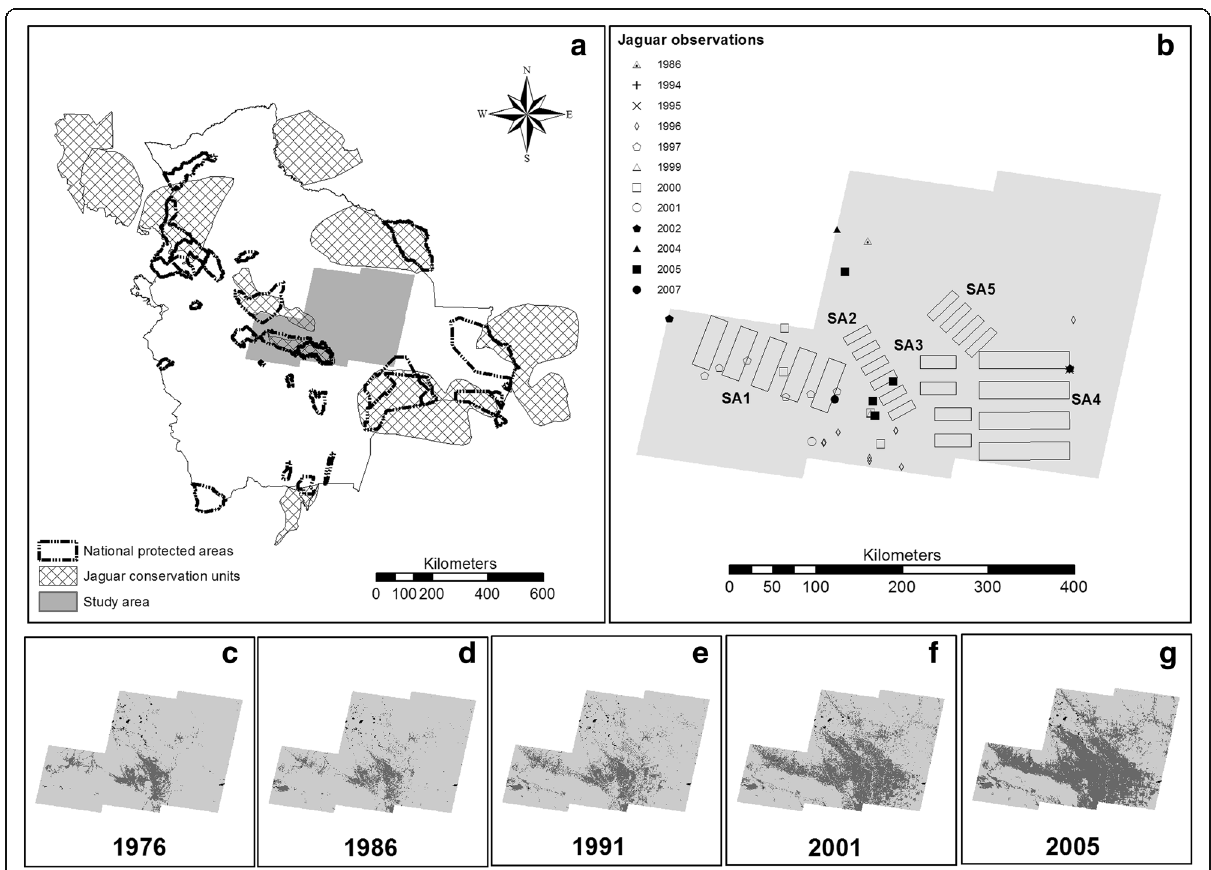
Fig. 1 Location of study area in Bolivia and within national protected areas and jaguar conservation units (Sanderson et al 2002, Rabinowitz and Zeller 2010) ( a ). Jaguar observations between 1986 and 2005 and study area with sampled location ( b ): Chapare region (SA1), northwest colonization zone (SA2), Santa Cruz integrated zone (SA3), southern expansion zone (SA4) and northern expansion zone (SA5). Deforestation are shown in dark grey in the study area for 1976 ( c ), 1986 ( d ), 1991 ( e ), 2001 ( f ) and 2005 ( g